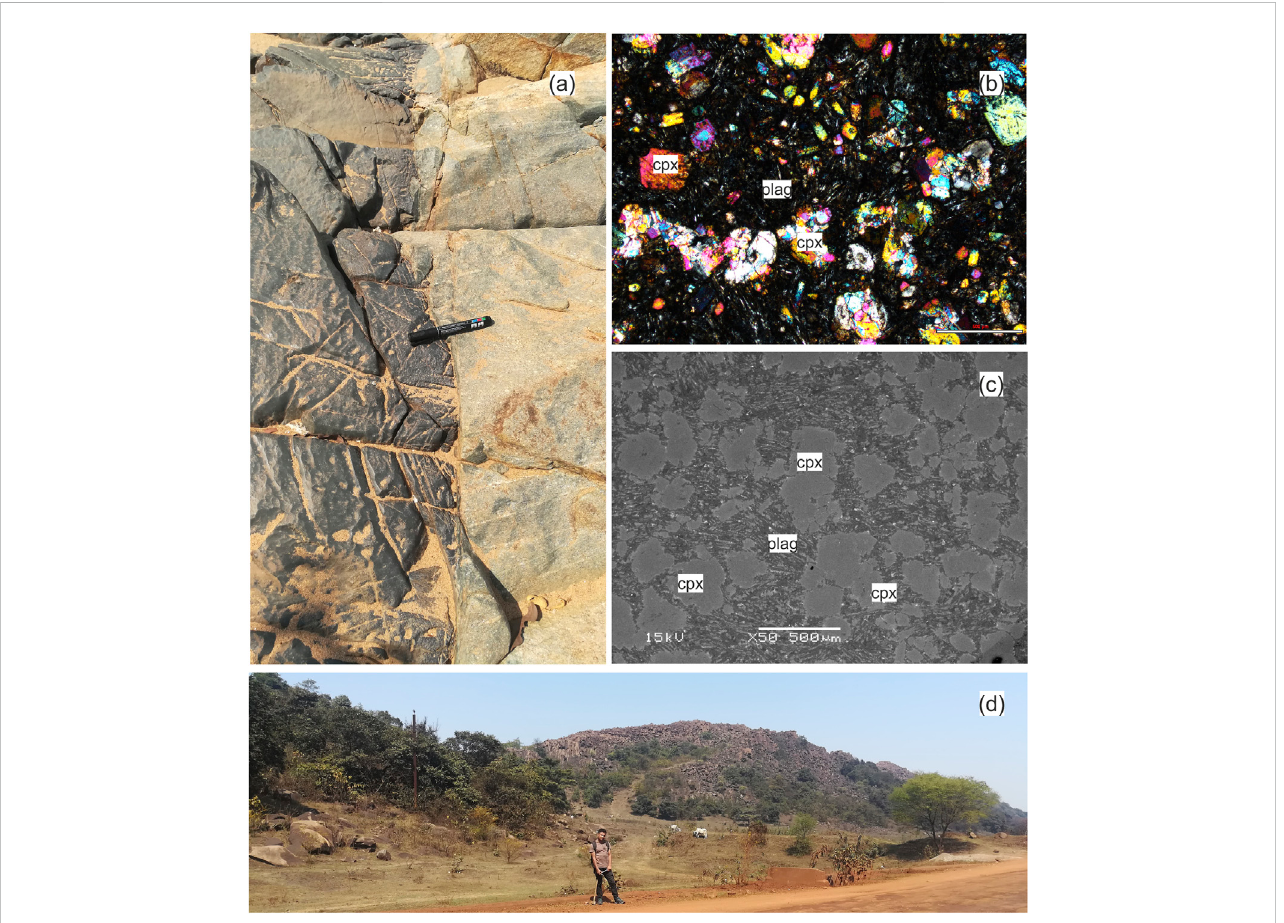
FIGURE 2 Field and petrographic images of the dyke swarms of Singhbhum craton. The fi eld photographs of (A) the Ghatgaon dyke swarm shows a cross-cutting relationshipwithPaleoarcheanTTGsand (D) theexposureoftheKeonjhardykeswarmintheDhurpadaarea. (B) Petrographicand (C) backscatteredimagesof the Ghatgaon dyke swarm (KD-09) show the clinopyroxene phenocrysts and the groundmass dominantly of